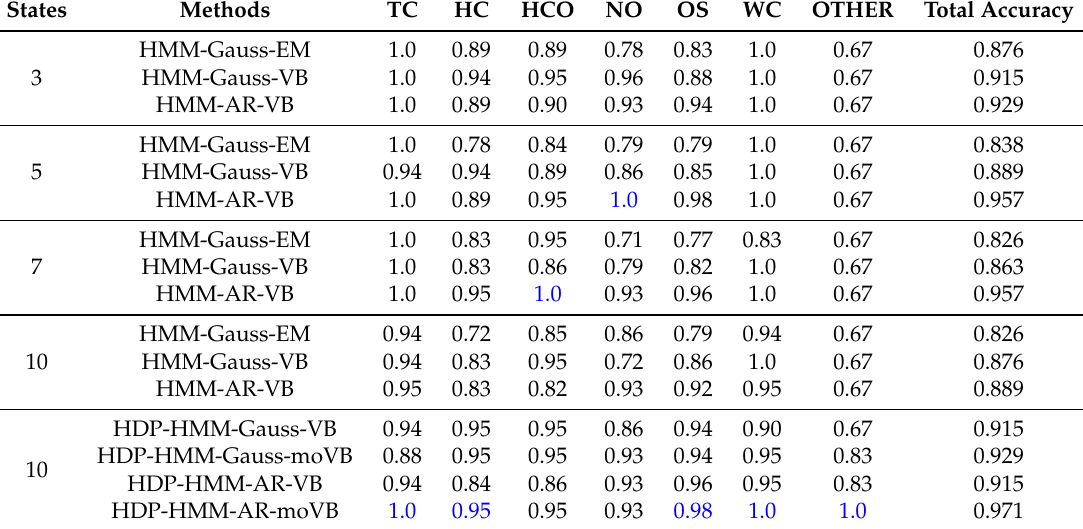
Table 2. The classification accuracy of both classical parametric HMMs and non-parametric HMMs. The best model (observation model and number of hidden states) for each anomaly type is highlighted in